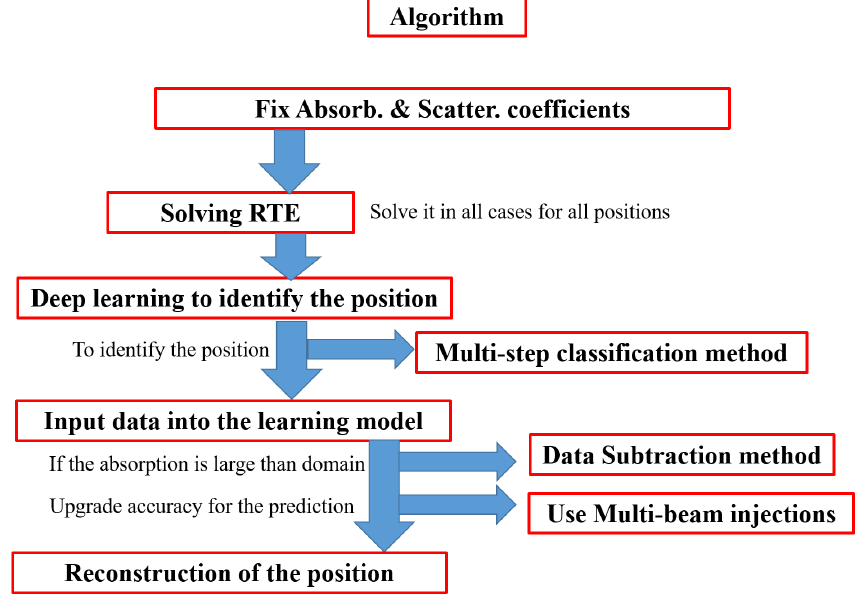
Figure 5. The algorithm of the present deep learning based on the LSTM